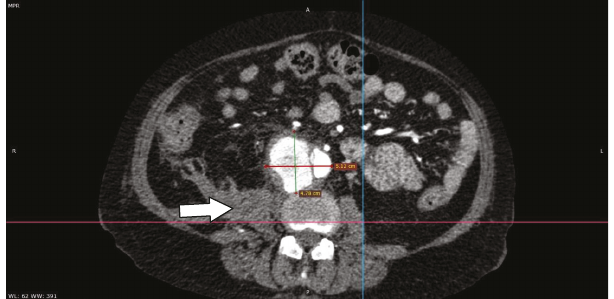
Figure 3: This is an axial view at the level of L4, demonstrating the saccular aneurysm at its maximal caliber of 5 1 × 4 8 cm ( W × AP ). An intimal fl ap is seen along the right lateral aspect of this dilatation. The saccular component of the aneurysm arises from the false lumen and is oriented anterolaterally to the right. No de fi nite perivascular contrast extravasation is appreciated indicating that the point of rupture has likely been walled o ff . A heterogenous, predominantly hypodense fl uid collection exhibiting minimal peripheral enhancement is appreciated at the right retroperitoneum, probably subacute hematoma